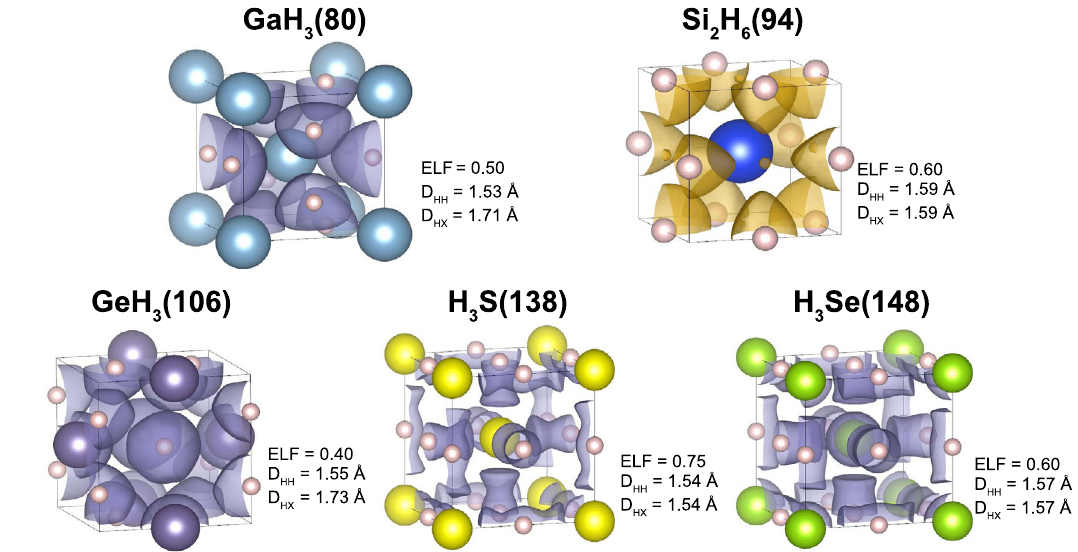
Fig. 3 Highly symmetric high- T c systems. This fi gure shows fi ve compounds related to the T c spike around a hydrogen – hydrogen distance of 1.55 Å . The pink spheres refer to hydrogen atoms, while the rest refer to the respective host atoms. An ELF isosurface is depicted in each case. Also the shortest H – H ( D HH ) and H – X ( D HX ) distances are noted. Most of these compounds belong to the covalent family and show a purple ELF isosurface. The Si 2 H 6 compound is an electride (note the small ELF bubbles in empty sites) and its ELF isosurface is shown in